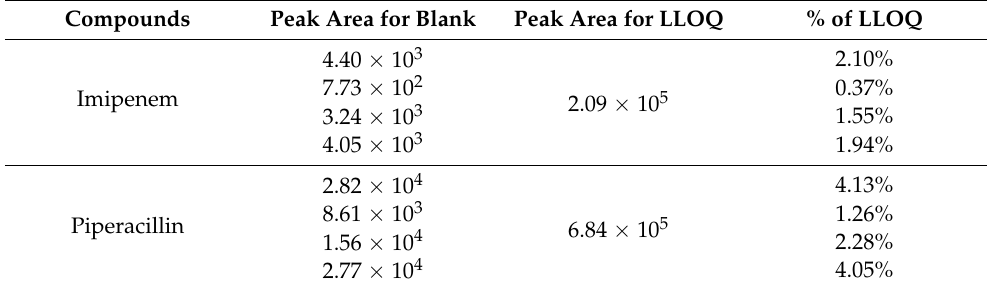
Table 5. Carryover presented as the ratio of Peak Area for blank and Peak Area for LLOQ. Compounds Peak Area for Blank Peak Area for LLOQ % of LLOQ 4.40 × 10 Imipenem